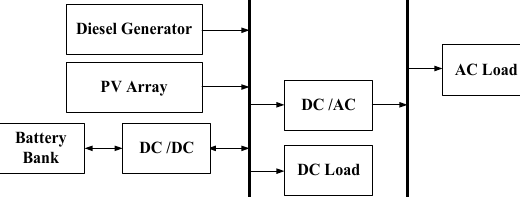
Figure 6. Block diagram of autonomous hybrid PV/diesel generator system/battery storage.